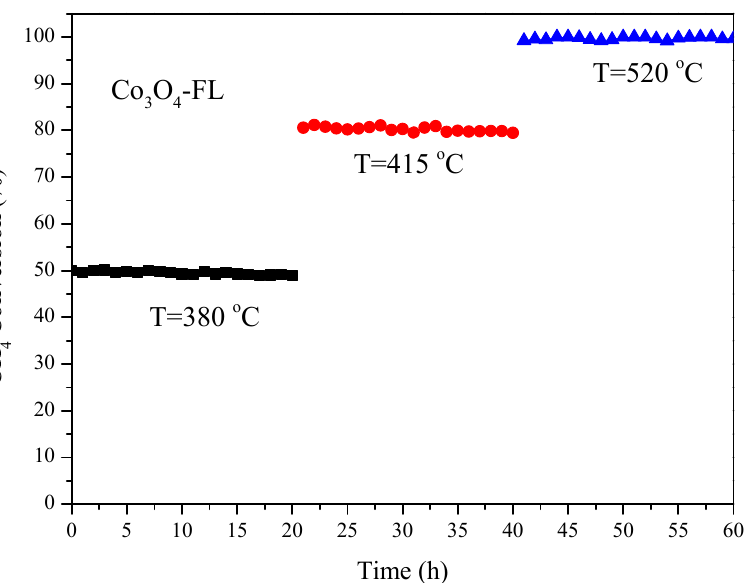
Figure 7. The catalytic stability of CH 4 oxidation over Co 3 O 4 -FLcatalysts at T 50 , T 80 and T 100 , respec- tively.